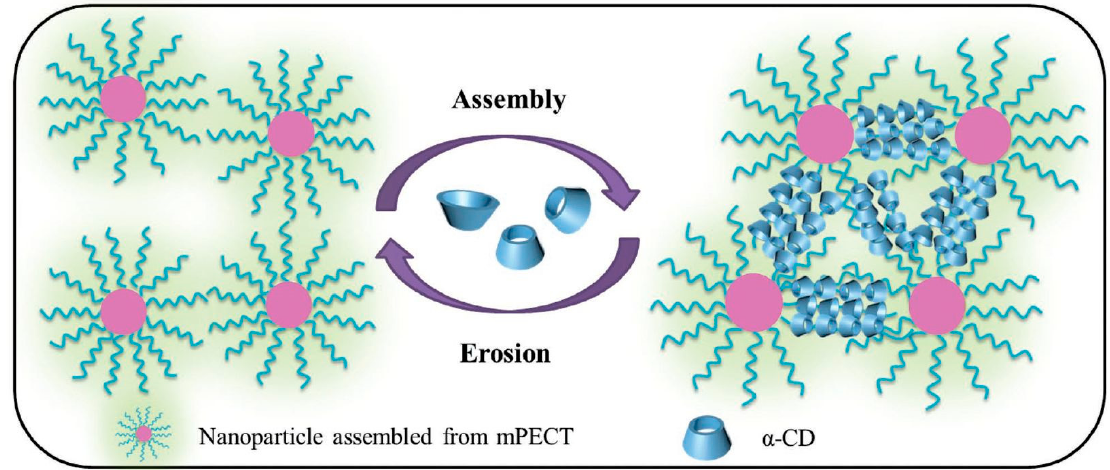
Figure 8. Illustration of the formation and structure of a polypseudorotaxane hydrogel composed of nanoparticles and α -CD. Adapted with permission from Macromol. Biosci . 2016 , 16 , 1188 − 1199 [154]. Copyright (2016) WILEY-VCH Verlag GmbH & Co. KGaA, Weinheim.